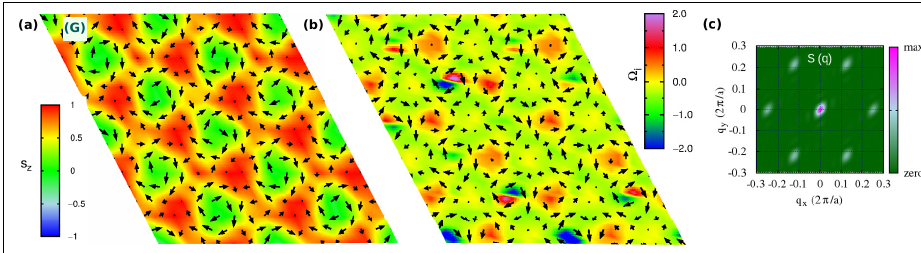
Figure 5. Topological lattice with | Q | m . u . c = 1.5. Similarly to Figure 3, snapshots at T = 1 K of the real-space spin configuration ( a ) and topological charge density Ω i ( b ), for the G-phase, i.e., a triple-( q ) state, consisting of a lattice of merons from the action of large easy-plane anisotropy and B z , as from the q = 0-peak in the S ( q ) ( c ), on the SK-lattice of the